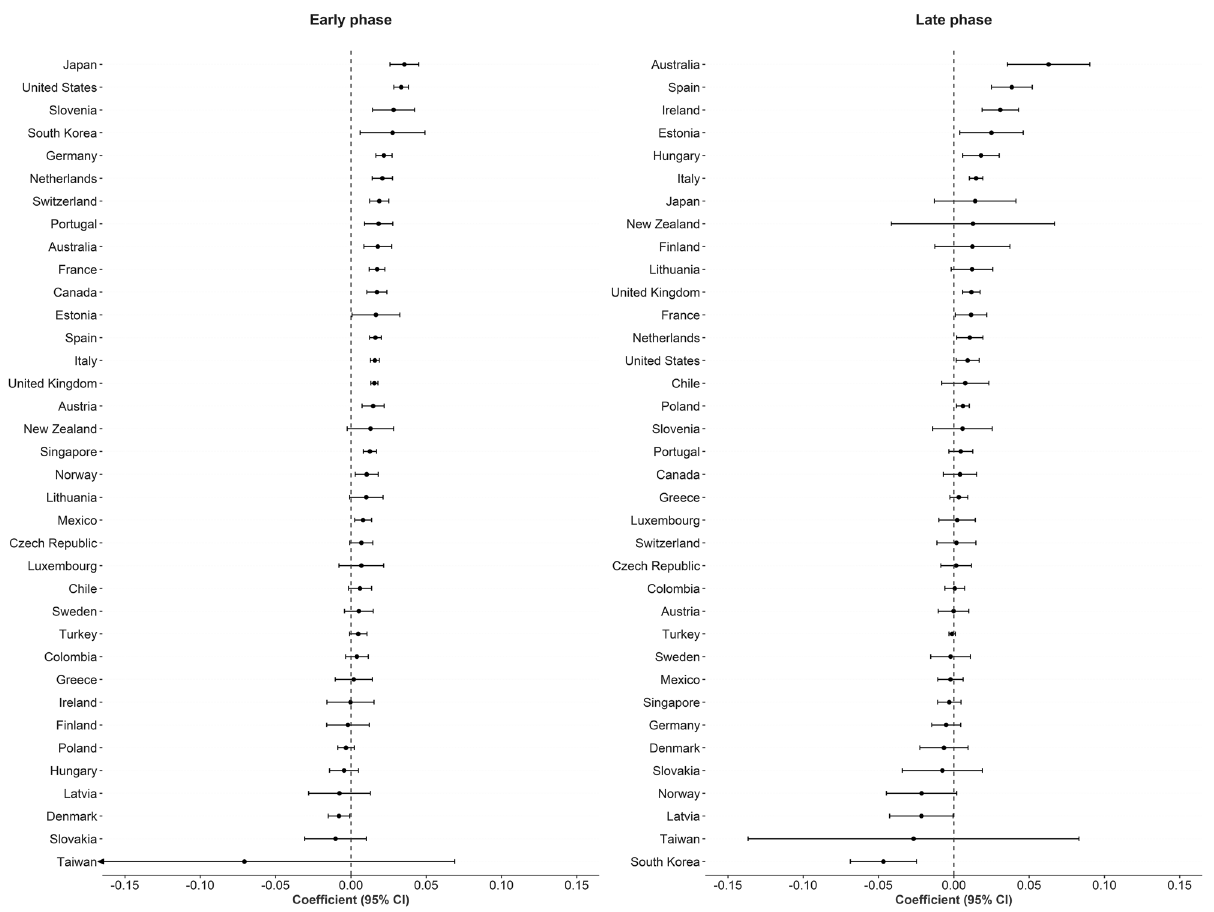
Figure 3. Forest plot showing unadjusted estimate for the association of COVID-19 case ratio logit- transformed with mobility changes. Footnote 1. The mobility change measurement period was from the day of the 100th case in each country through August 31, 2020. Footnote 2. Pandemic phase was defined for each country by the median of the date when the 100th case was detected to the end of the study period: early phase for the period before the median date and late phase for the period after the median